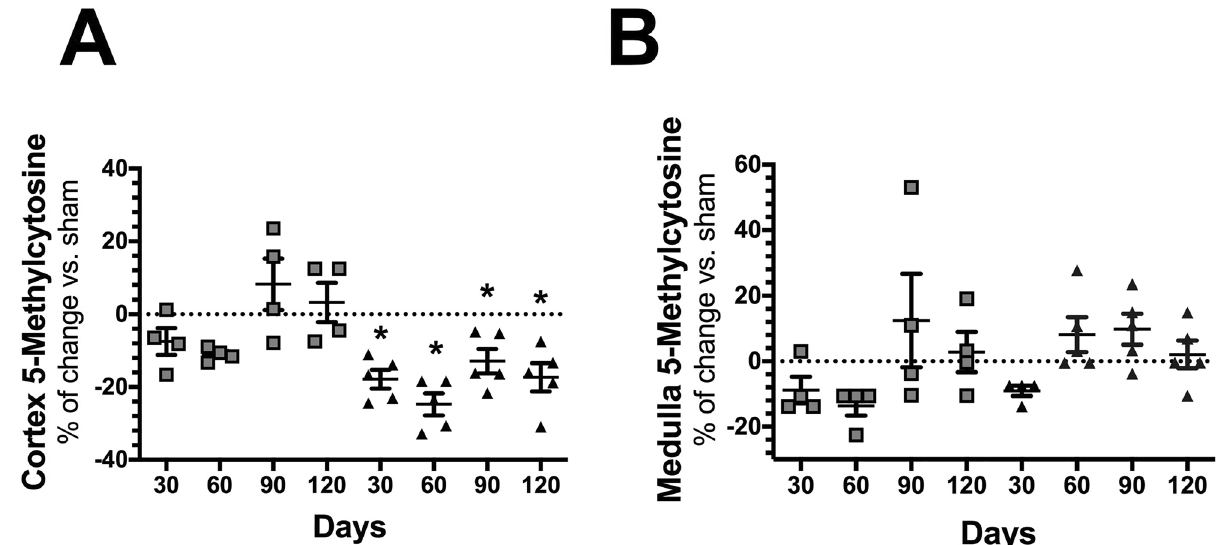
Figure 7. Global DNA methylation over the course of AKI to CKD transition. ( A ) Percentage change of global DNA methylation in renal cortex from the UNx (gray squares) and IR + UNx (black triangles) groups. ( B ) Percentage change of global DNA methylation in renal medulla from the UNx (gray squares) and IR + UNx (black triangles) groups, for each studied period: 30, 60, 90, and 120 days The one-way analysis of variance (ANOVA) was used to determine statistical differences, using the Bonferroni correction for multiple comparisons. * p < 0.05 versus S